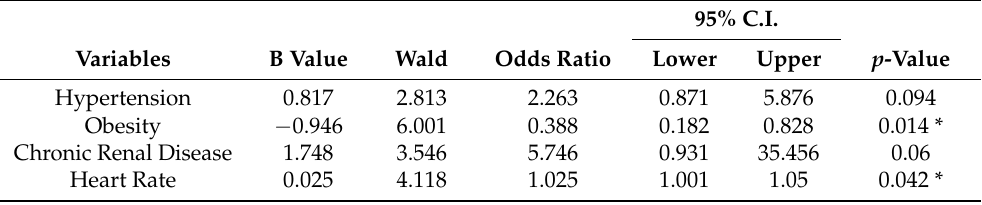
Table 3. Clinical factors associated with stroke severity in AIS patients with DBP ≤ 80 mmHg in the telestroke network. Adjusted OR < 1 denotes factors associated with not having an NIHSS score > 7, while OR > 1 denotes factors associated with having an NIHSS score > 7. Hosmer–Lemeshow test ( p = 0.318), Cox and Snell ( R 2 = 0.100). The overall classified percentage of 68.1% was applied to check for the fitness of the logistic regression model. * Indicates statistical significance ( p < 0.05) with a 95% confidence interval. Classification table (overall correctly classified percentage = 68.1%) and area under the ROC curve (AUC = 0.670, 0.593–0.746) were applied to check model fitness. 95% C.I.